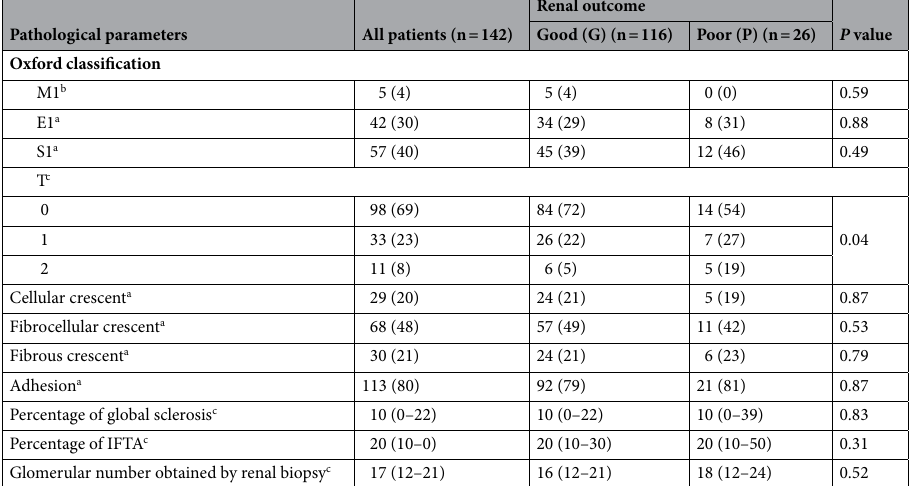
Table 4. Pathological features. Data are n (%), or median (inter-quartile range) unless otherwise indicated. Oxford classification; M1, Mesangial hypercellularity score > 0.5; E1, any endocapillary hypercellularity; S1, any segmental sclerosis; T, tubular atrophy and interstitial fibrosis (T0 ≤ 25%, 25% < T1 ≤ 50%, T2 > 50% of cortical area); IFTA, interstitial fibrosis/tubular atrophy. a Pearson’s chi-square test. b Fisher’s exact test. c Wilcoxon test.